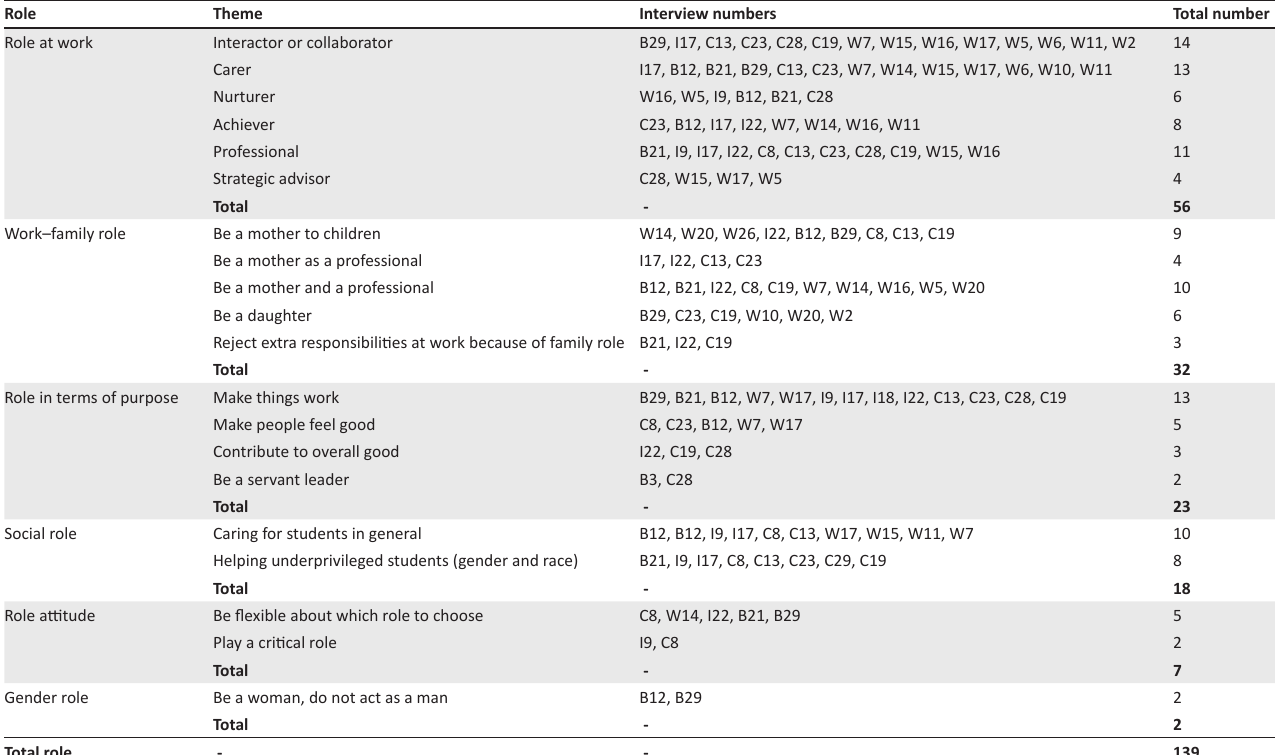
TABLE 8: Role of women leaders.